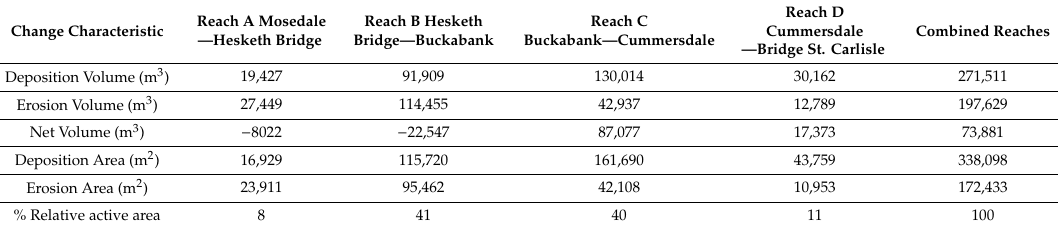
Table 2. Summary gross topographic change statistics for the River Caldew between 2005 and 2016.